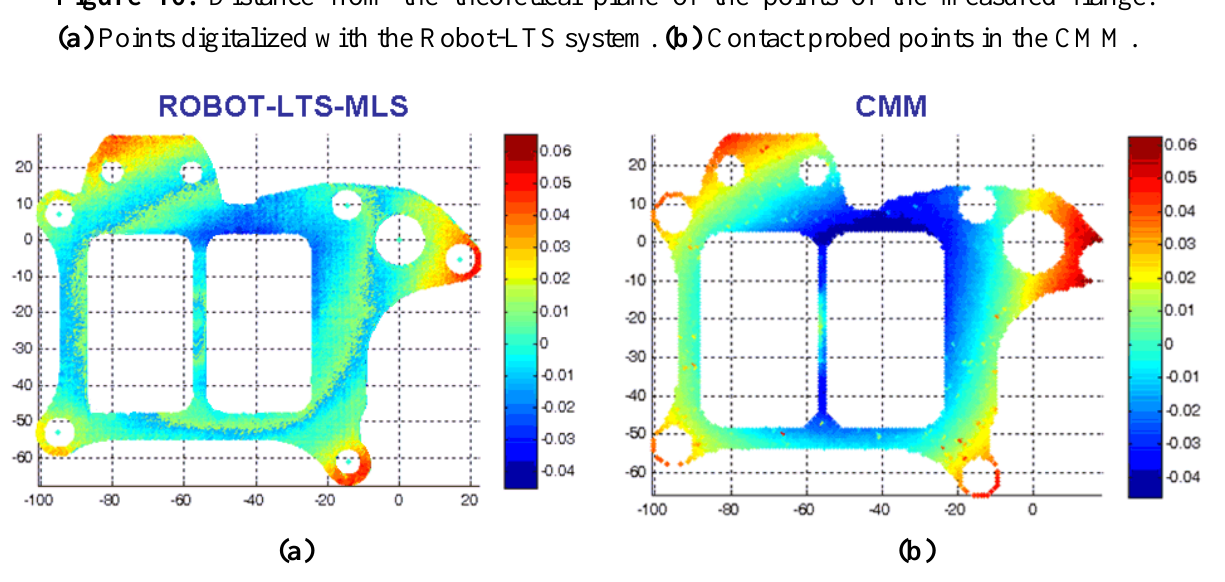
Figure 16. Distance from the theoretical plane of the points of the measured flange.